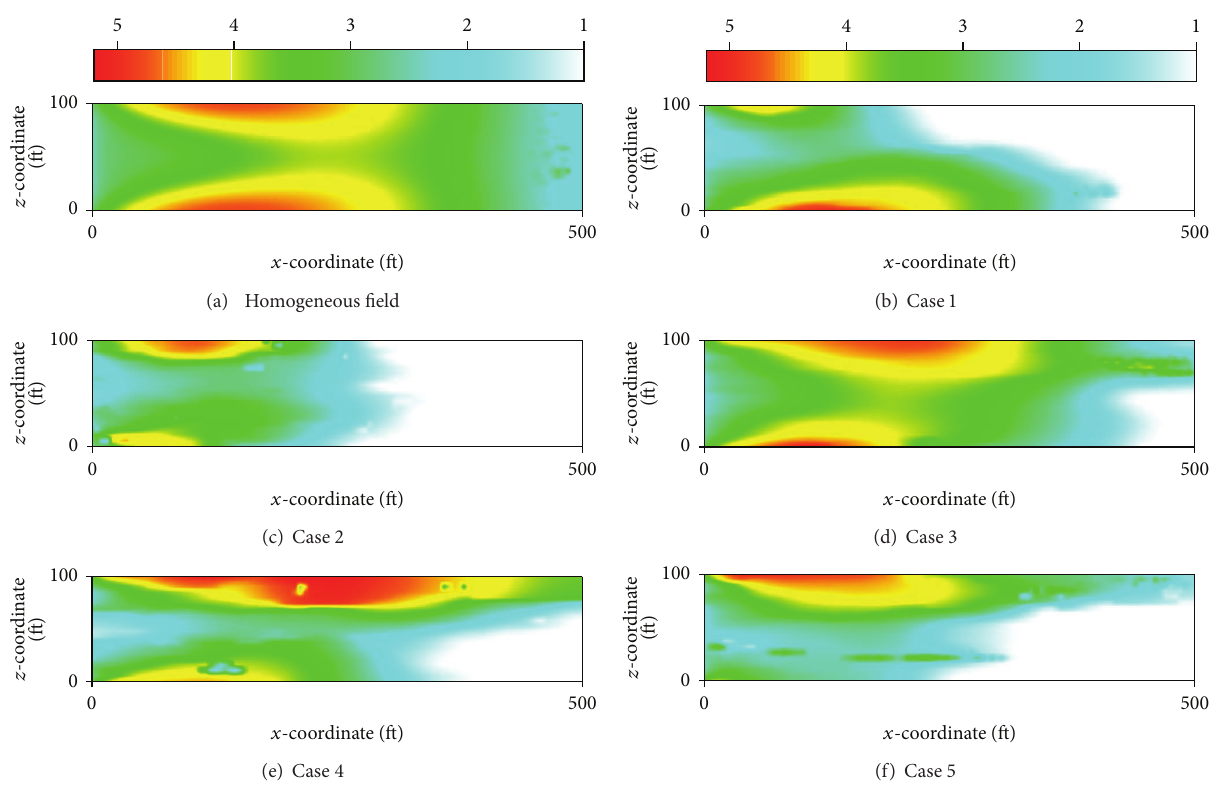
Figure 4: Permeability reduction factors depending on heterogeneity at 1,000 days.